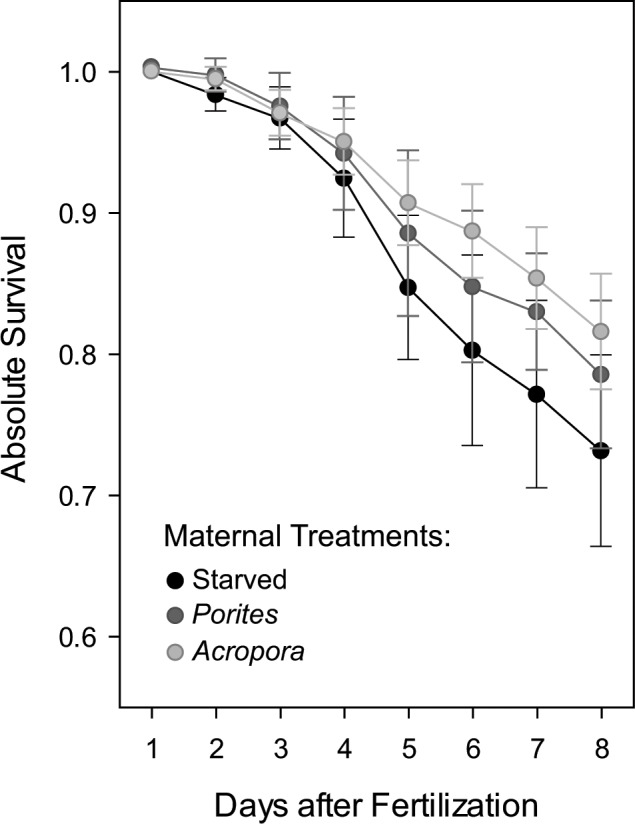
Daily survival rates of larvae reared for eight days.Data points are mean values ± 1SD of pooled proportions of surviving larvae from all females and rearing jars under each maternal nutrition treatment (n = 9).